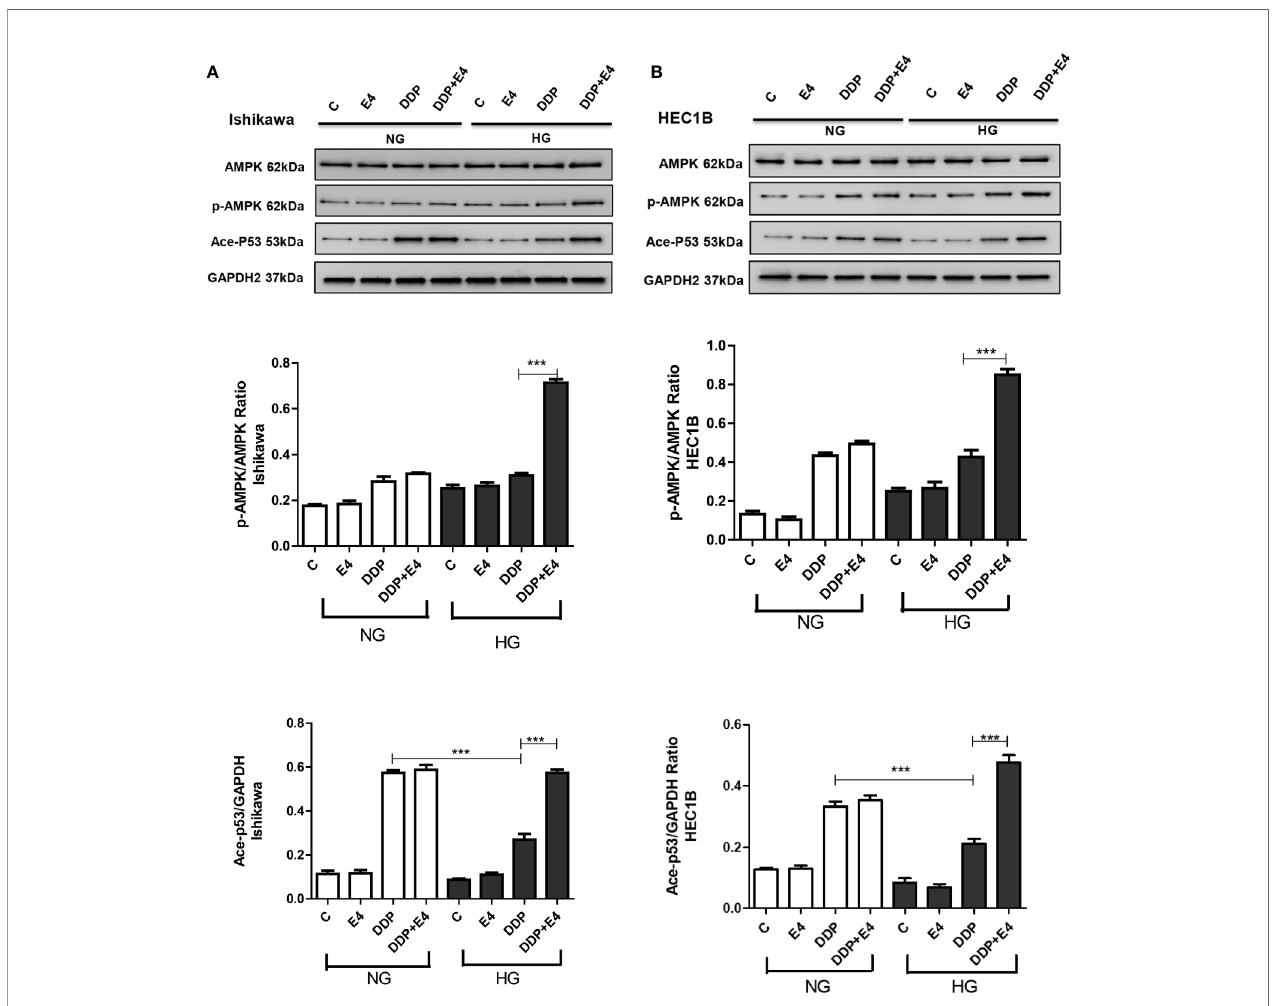
FIGURE 6 | Effects of high glucose (HG), DDP, and Exe-4 on AMPK, p-AMPK, and acetylated P53 levels in Ishikawa and HEC1B cells. Protein levels were assessed by immunoblot, with GAPDH as a loading control. Data for Ishikawa (A) and HEC1B (B) cells are shown. Measurements were performed in triplicate. ***p < 0.001, DDP in HG vs. DDP in NG, DDP+Exe-4 vs. DDP in